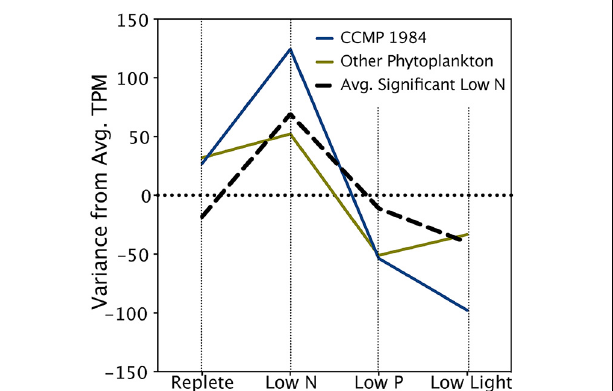
FIGURE 3 | Expression patterns of key nitrogen metabolism transcripts. The black hashed line denotes the mean variance in expression across treatments of transcripts significantly upregulated in the low N treatment. Significance was determined with ASC using a fold change greater than or equal to 2 and a posterior probability greater than 0.95 (Wu et al., 2010). The blue line denotes the average variance in expression of transcripts from this study with functional annotations previously determined to be significantly upregulated during low N conditions in A. anophagefferens CCMP 1984 (Berg et al., 2008; Wurch et al., 2011b) (See Table 5 ). The green line denotes the variance in expression of transcripts from this study with functional annotations identified as upregulated during low N conditions in diatoms or coccolithophores (Dyhrman et al., 2006, 2012; Allen et al., 2011; Bender et al., 2014) (See Table 5